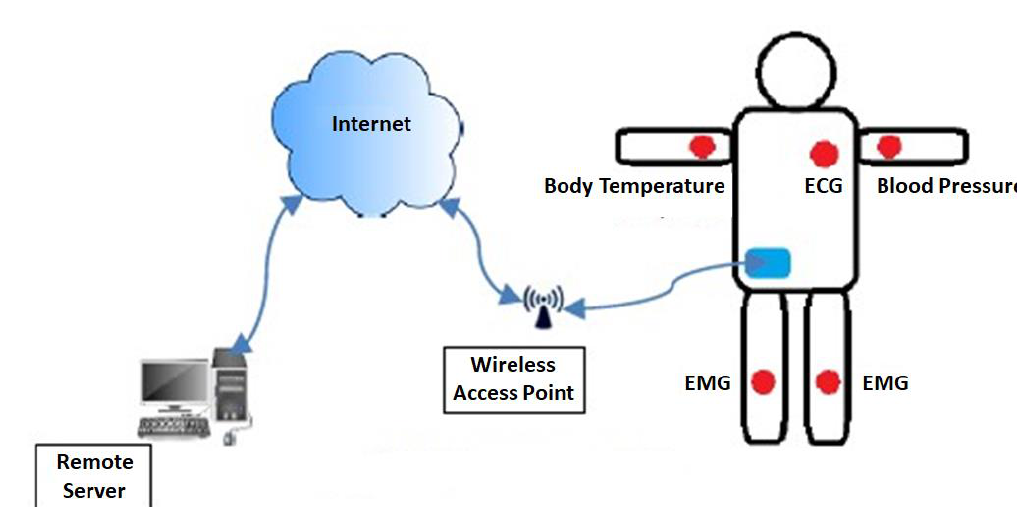
Figure 1. Wireless Body Area Networks (WBAN) basic architecture depicting deployment of sensors for gathering patient’s data and submitting it to a remote server via the internet.